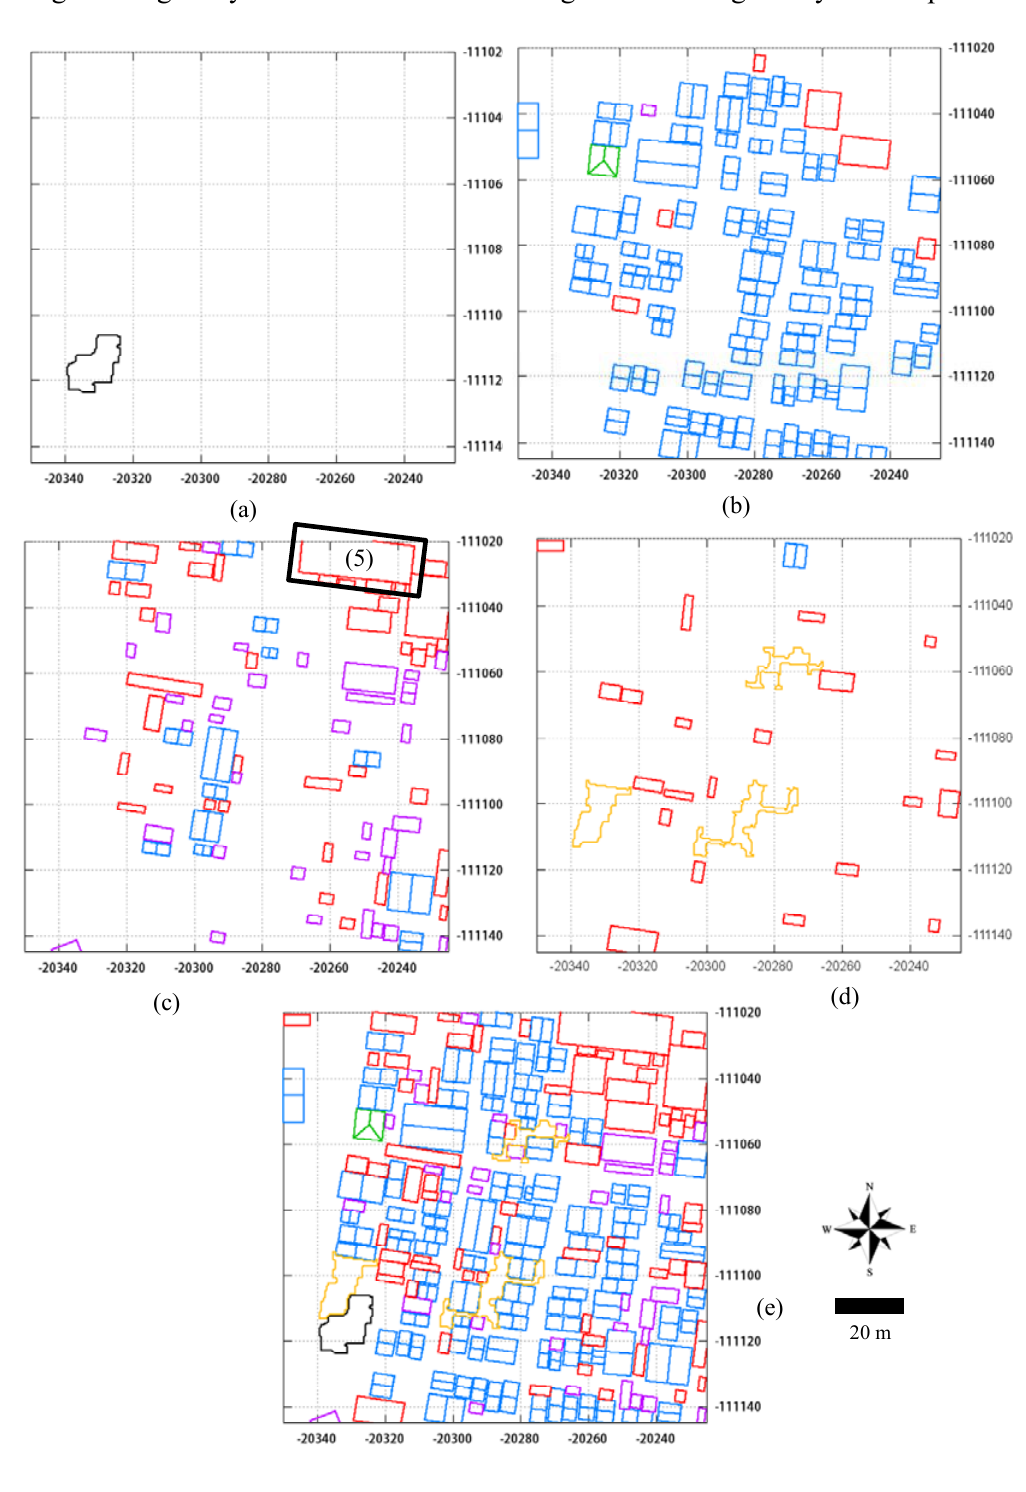
Figure 10. Wireframe models generated by the proposed algorithm on the area of Figure 8. ( a – d ) show models in “Modeling (1)” to “Modeling (4)” of Figure 1, and ( e ) shows models of ( a ) to ( d ). In the models, red denotes a flat-roof building, blue denotes a gable-roof building, green denotes a hip-roof building, pink denotes a slant-roof building, black denotes a flat big building and yellow denotes a flat model generated using finally unused